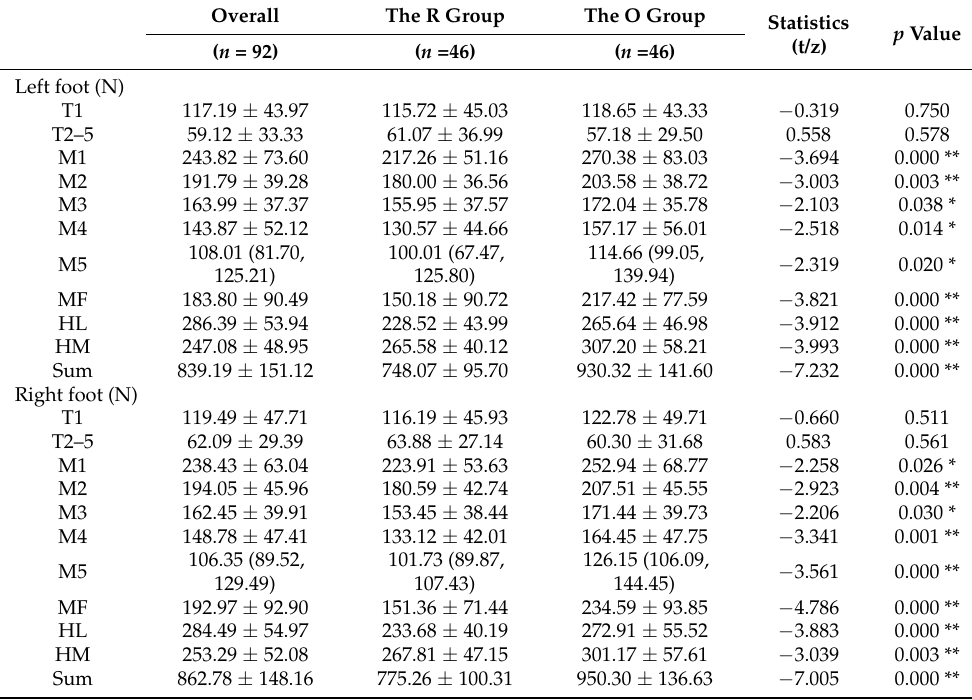
Table 7. Peak force of the older women in the O and R groups.